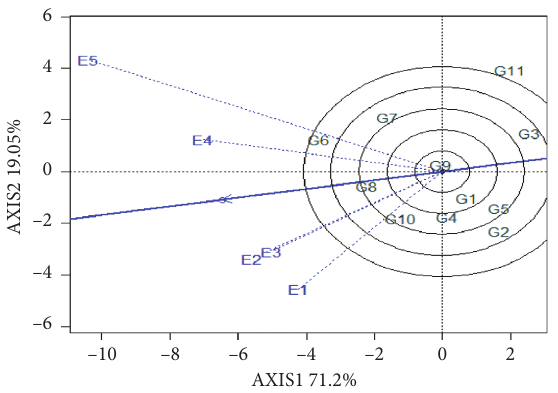
Figure 1: Discriminativeness vs. representativeness view of GGE biplot of genotypes across test environment. The biplot based on scaling � 0; centering � 2; SVP � 2; genotypes: G1 � 95/0194, G2 � 95/18544, G3 � 95/18922, G4 � 95/18949, G5 � 95/19156, G6 � 95/19158, G7 � 95/19177, G8 � 96/00594, G9 � 96/02025, G10 � 96/02610, and G11 � Laribako ; and environments: E1 �